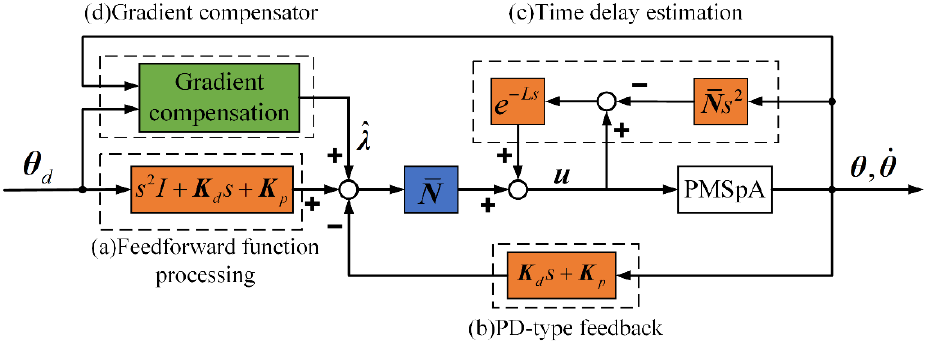
Figure 4. Controller system block diagram: ( a ) Feedforward function processing, ( b ) PD-type feedback, ( c ) Time delay estimation, and ( d ) Gradient compensator.